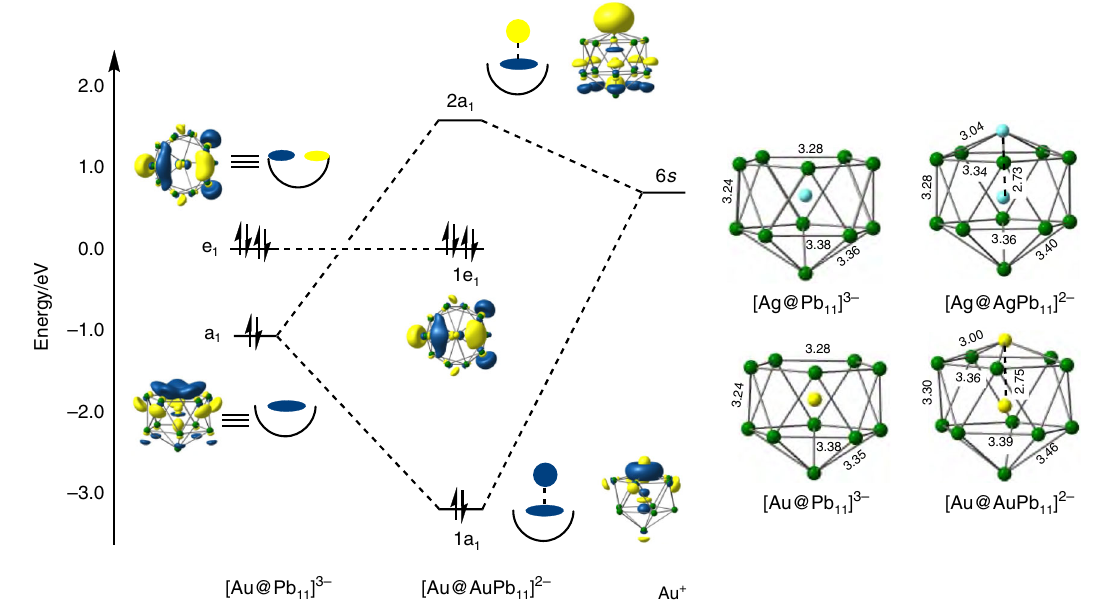
Fig. 6 Electronic structure analysis of [M@Pb 11 ] 3 − and [M@MPb 11 ] 2 − . Optimized structures of [M@Pb 11 ] 3 − and [M@MPb 11 ] 2 − , and a Kohn – Sham molecular orbital diagram showing the interaction between Au + and the nido -icosahedral fragment [Au@Pb 11 ] 3 − . The doubly degenerate e 1 orbitals are viewed down the principal